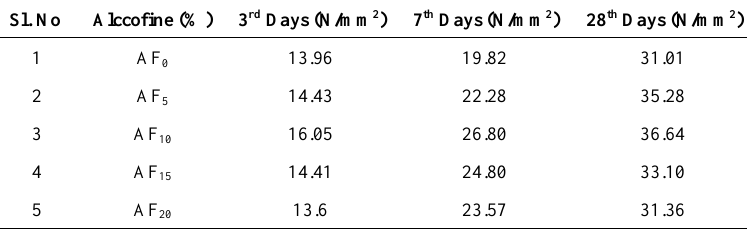
Table 11. Compressive strength test for mortar cubes (PPC AF RS).